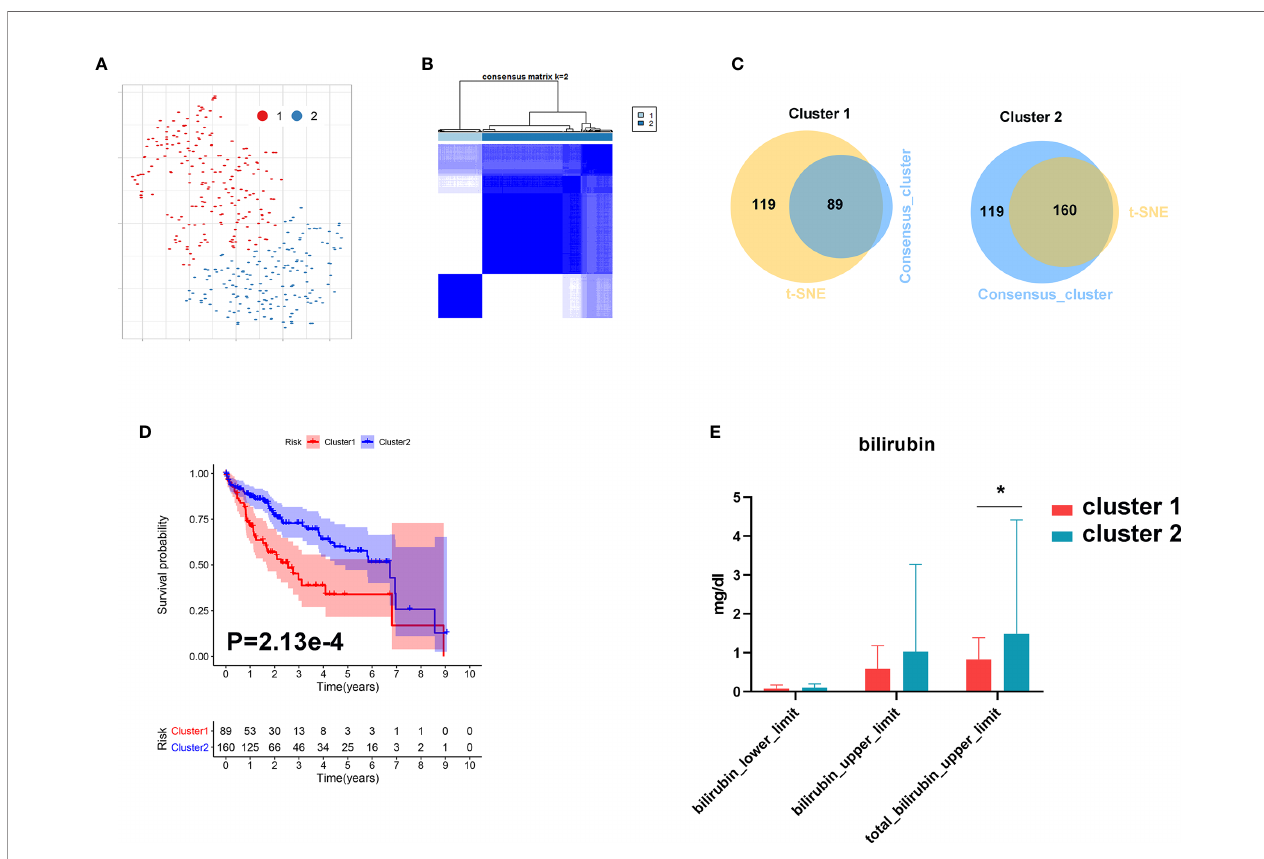
FIGURE 8 | Metabolic subgroup of HCC based on primary bile acid biosynthesis. (A) Dot plot for two distinct clusters identi fi ed by t-SNE. (B) Heat map for two distinct clusters identi fi ed by consensus clustering solution. (C) Venn plot for identifying common samples in the two clusters. (D) Kaplan – Meier survival analysis for patients in two clusters. (E) The levels of bilirubin between the two clusters. * P <